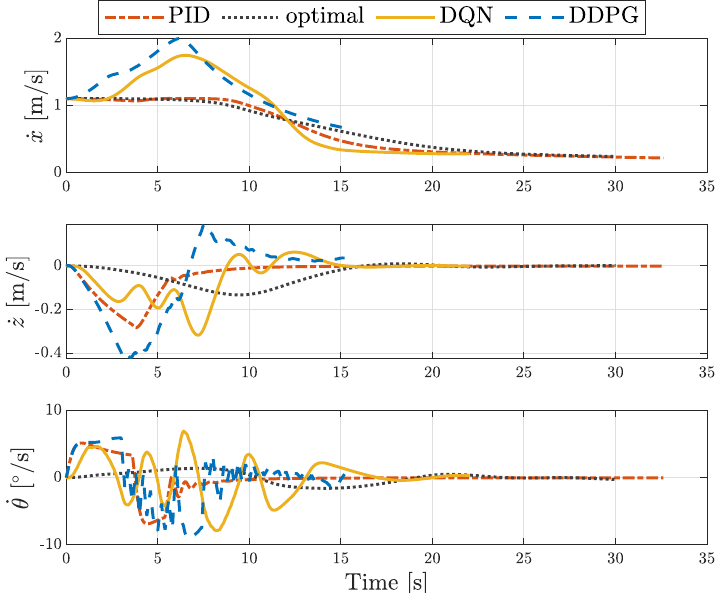
Figure 10. Translational and rotational velocity of the AUV during docking with different control